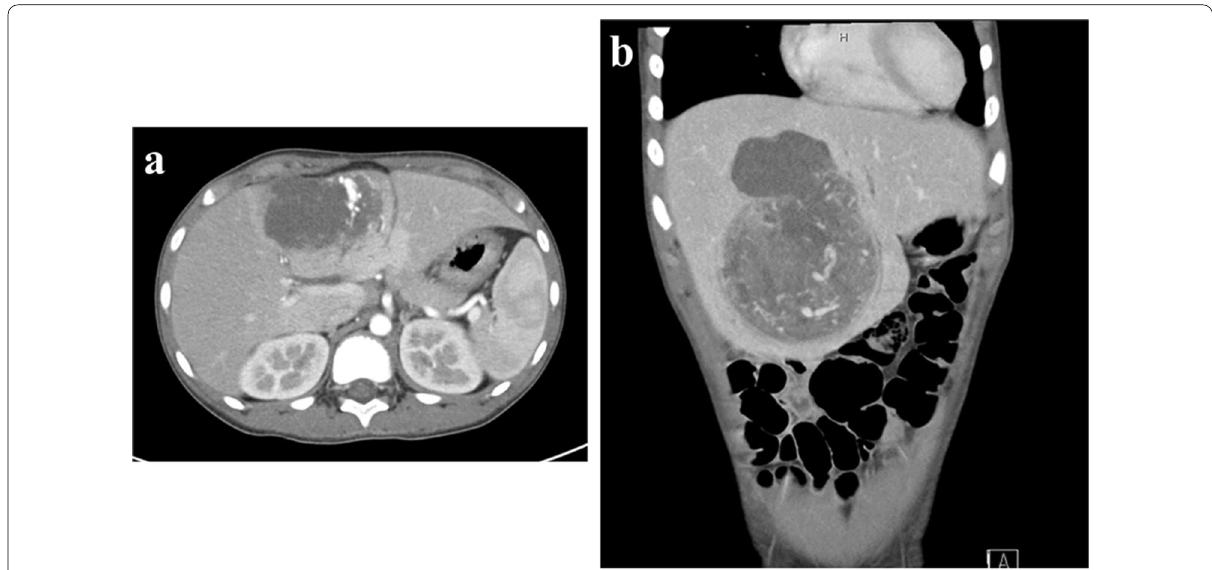
Fig. 1 CT findings. CT shows a 7.7 weak enhancement in both the arterial and portal phases ( b